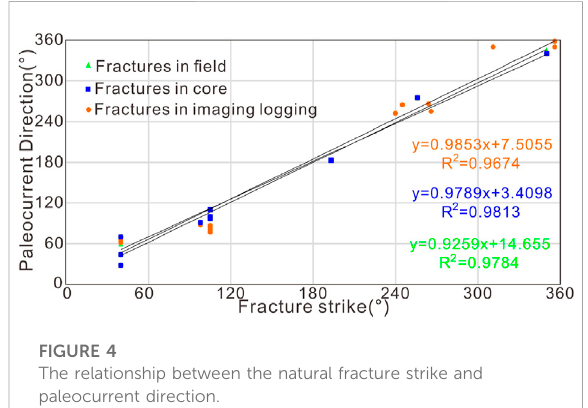
FIGURE 4 The relationship between the natural fracture strike and paleocurrent direction.